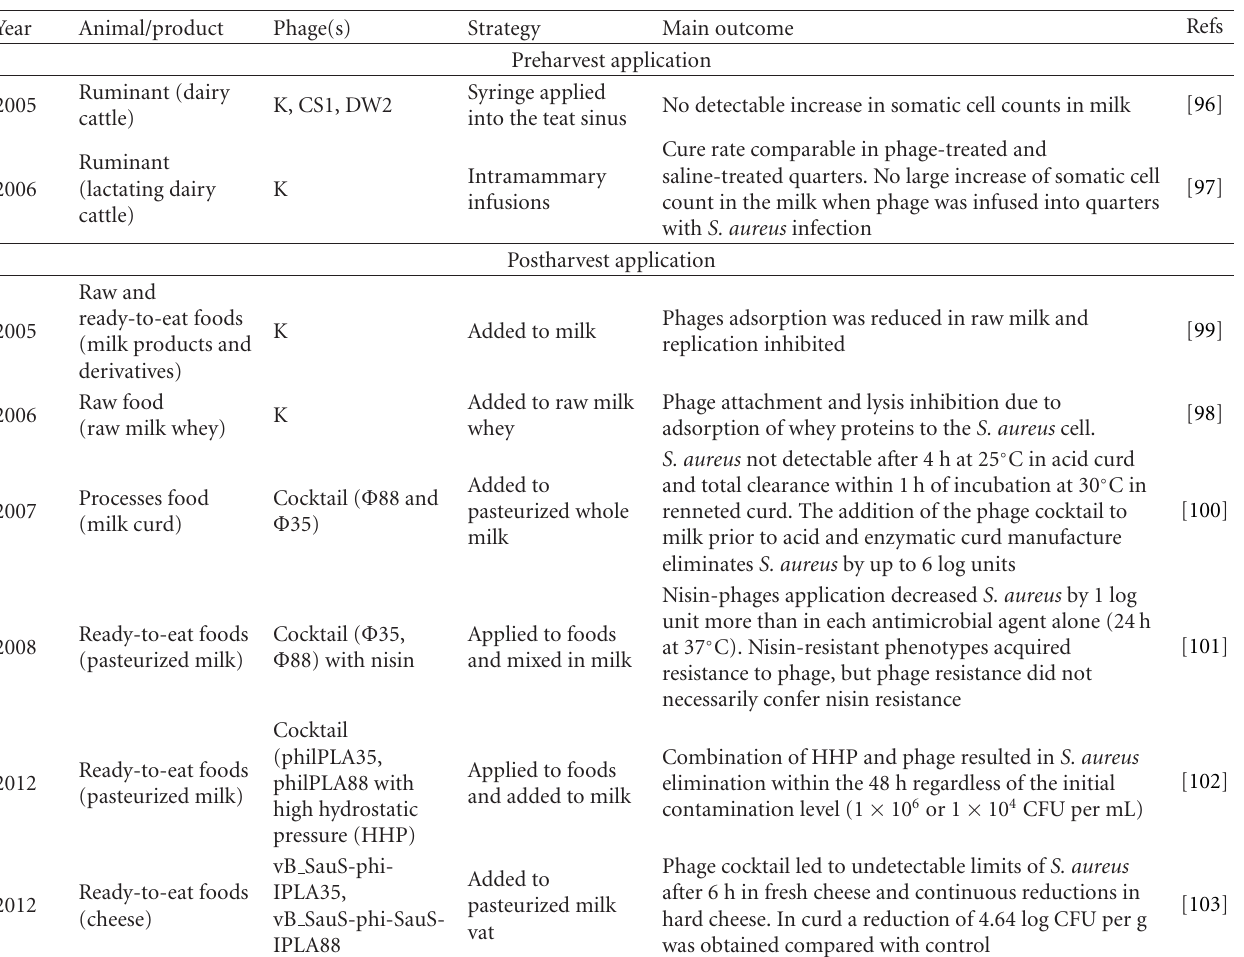
Table 5: Preharvest and Postharvest Staphylococcus aureus phage